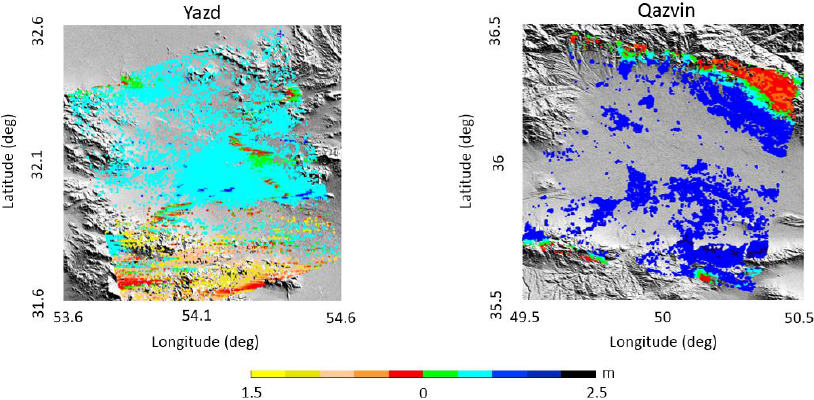
Figure 8. A typical example of computed tropospheric delay using the advanced integration technique on 2018-01-04 .